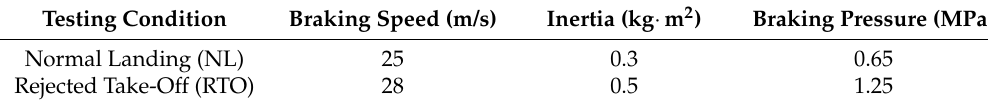
Table 1. Friction testing conditions.